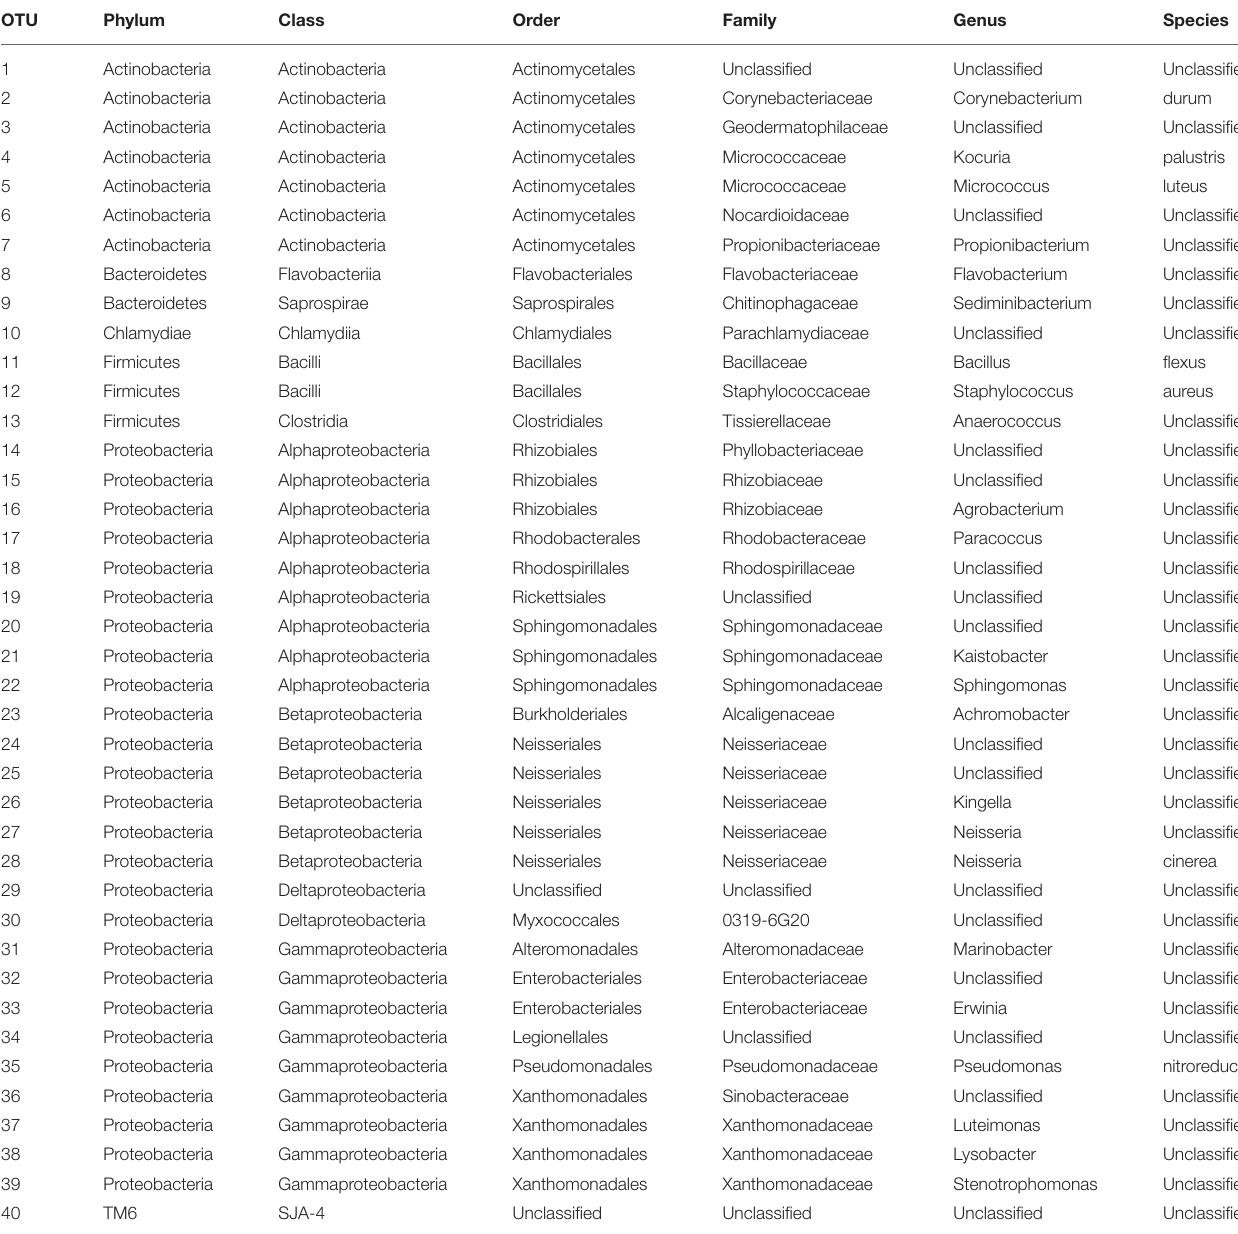
TABLE 2 | OTUs transmitted from source (SRC) to sink plants (STEMSNK and ROOTSNK) by S. titanus. OTU